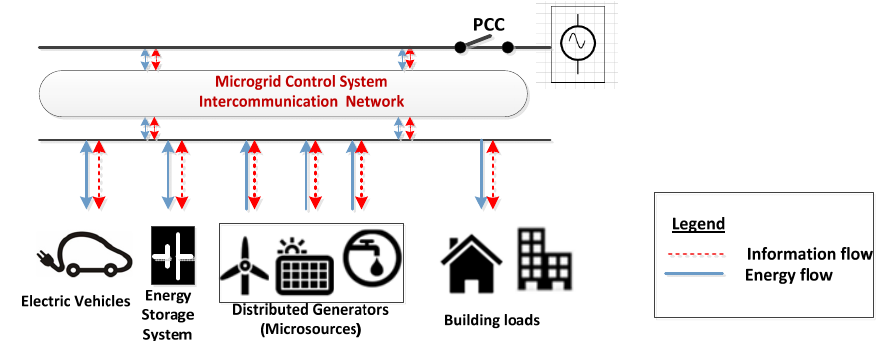
Figure 1. Simplified scheme of a microgrid.